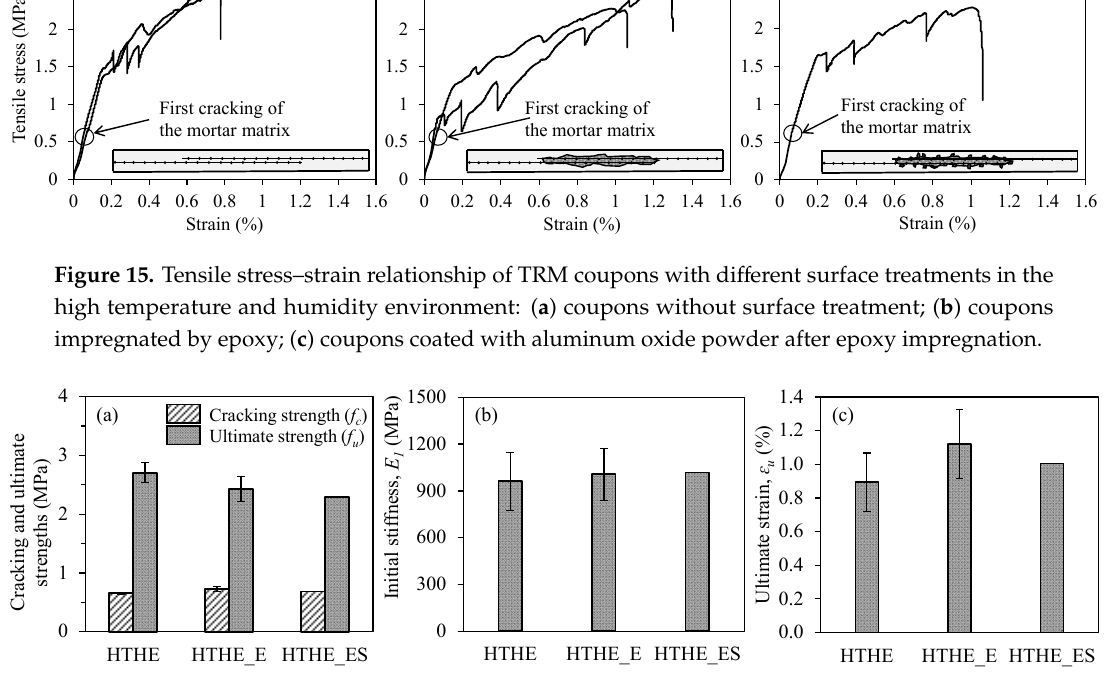
Figure 16. Effect of different surface treatments on the tensile behavior of TRM coupons in the high temperature and humidity environment: ( a ) cracking and ultimate strength; ( b ) initial stiffness; ( c ) ultimate strain.